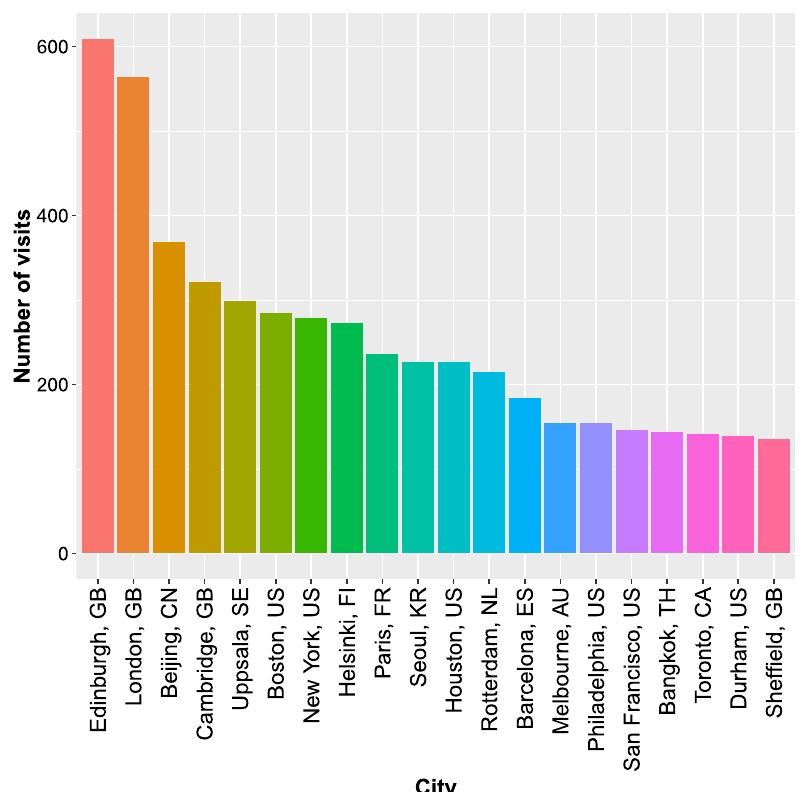
Figure 2. The top 20 cities of origin of visitors to the GenABEL website in the period 28 April 2015 – 28 April 2016. Only visits lasting more than 60 seconds and from cities from which more than 15 visits originated were taken into account. The total number of visits in that period was 16319, of which 696 came from unknown cities. Each city name is followed by the two-letter ISO code of the country in which it is